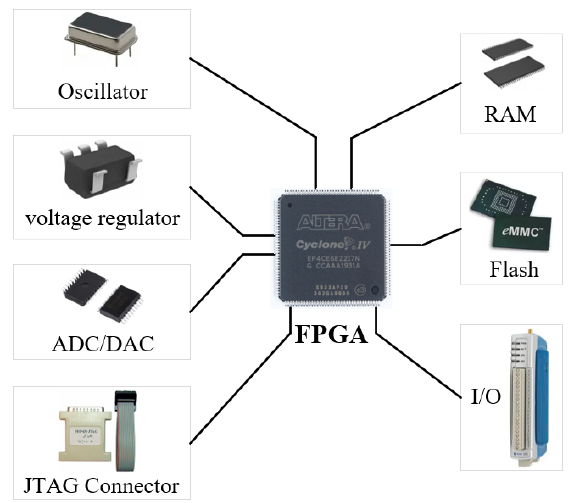
Figure 8. Hardware block diagram of the control system.